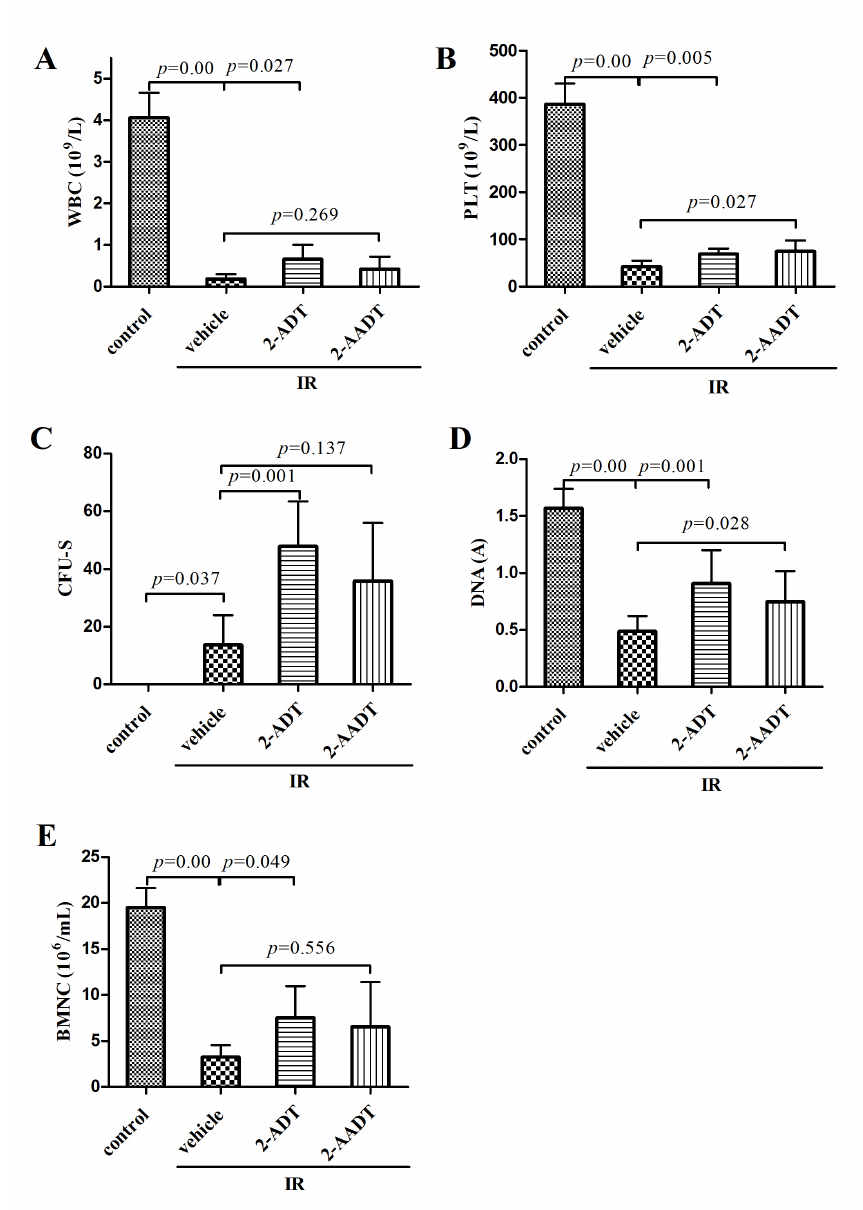
Figure 2. Effects of 2-ADT and 2-AADT on hematopoietic system. ( A ) WBC counts; ( B ) PLT counts; ( C ) CFU-S counts; ( D ) DNA content and ( E ) BMNC counts of irradiated and control mice 7 days after treatment. 2-ADT and 2-AADT were administered i.p. 30 min before 6.0 Gy irradiation. Results are expressed as the mean ± SD ( n = 8 each). One-way ANOVA was used for statistical comparisons between groups. the p value indicates the difference compared with the IR + vehicle